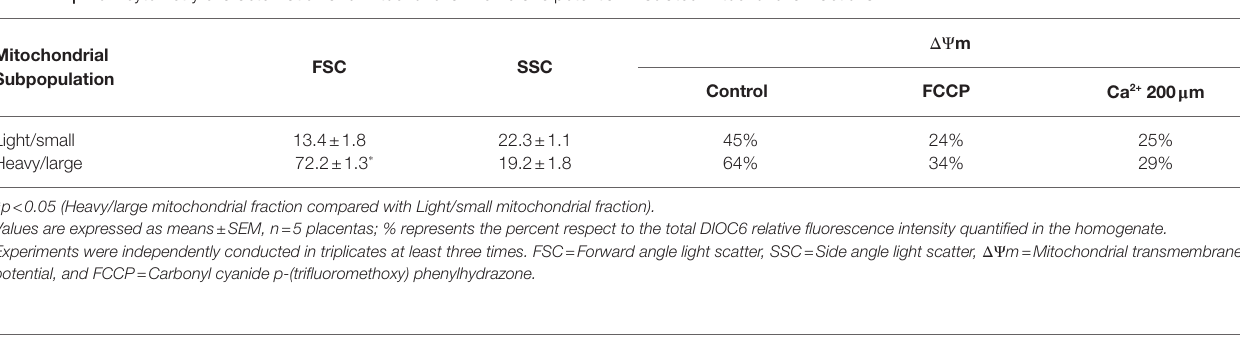
FIGURE 3 | TUNEL assay. (A) Representative images and (B) % of apoptotic nuclei for each treatment were shown. TUNEL positive cells (red); stroma nuclei stained with DAPI (blue). Image magnification: ×1,000. Data are expressed as means ± SEM. ( n = 6 placentas; *** p < 0.001 compared to control without AQP9 blockers, NS = Non-significant; and ### p < 0.001 compared to low glucose medium with L-lactic acid without